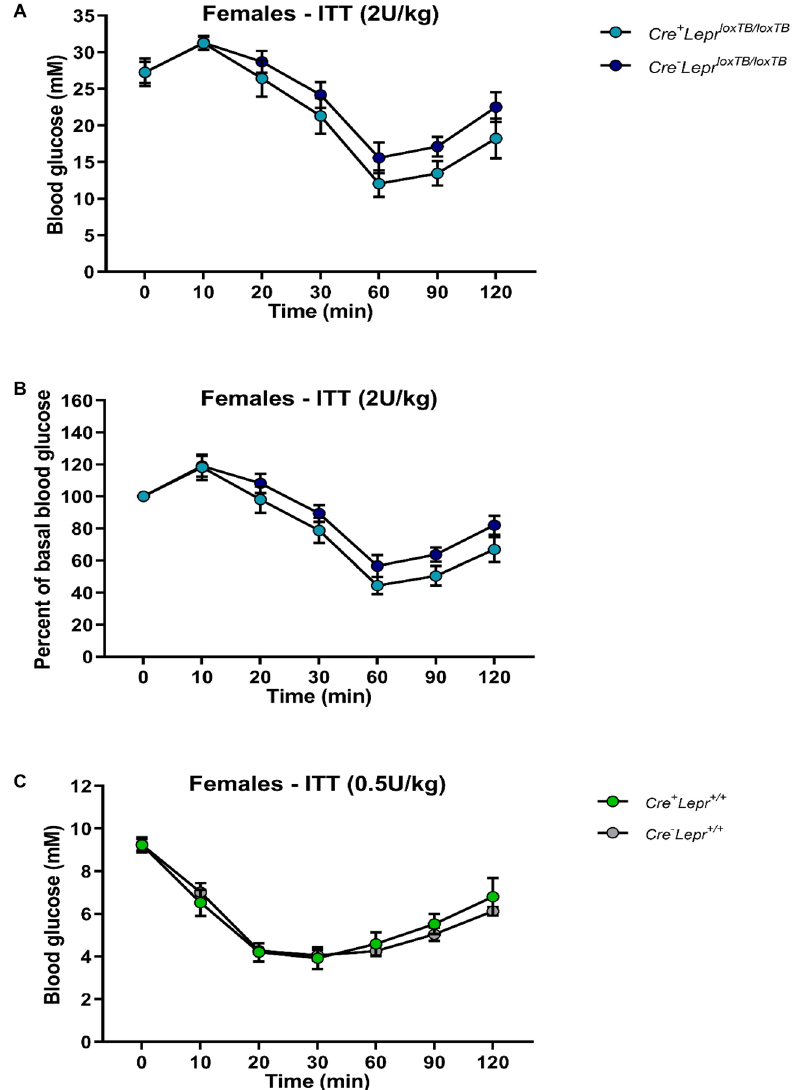
Figure 3. Insulin tolerance tests (ITTs) in female mice from the Lepr reconstitution study. In ( A ), the insulin dose was 2U per kg of body weight. In ( B ), blood glucose concentration of each mouse in ( A ) was normalized to its basal (0 min) blood glucose concentration. In ( C ), the insulin dose was 0.5 U per kg of body weight. In ( A ) and ( B ), n = 8 for Cre + Lepr loxTB/loxTB and n = 15 for Cre − Lepr loxTB/loxTB ; in ( C ), n = 10 for Cre + Lepr + / + and n = 11 for Cre − Lepr + / + . Performed repeated measures two-way ANOVA with post-hoc analysis. Main effect of time (p < 0.05) in ( A – C